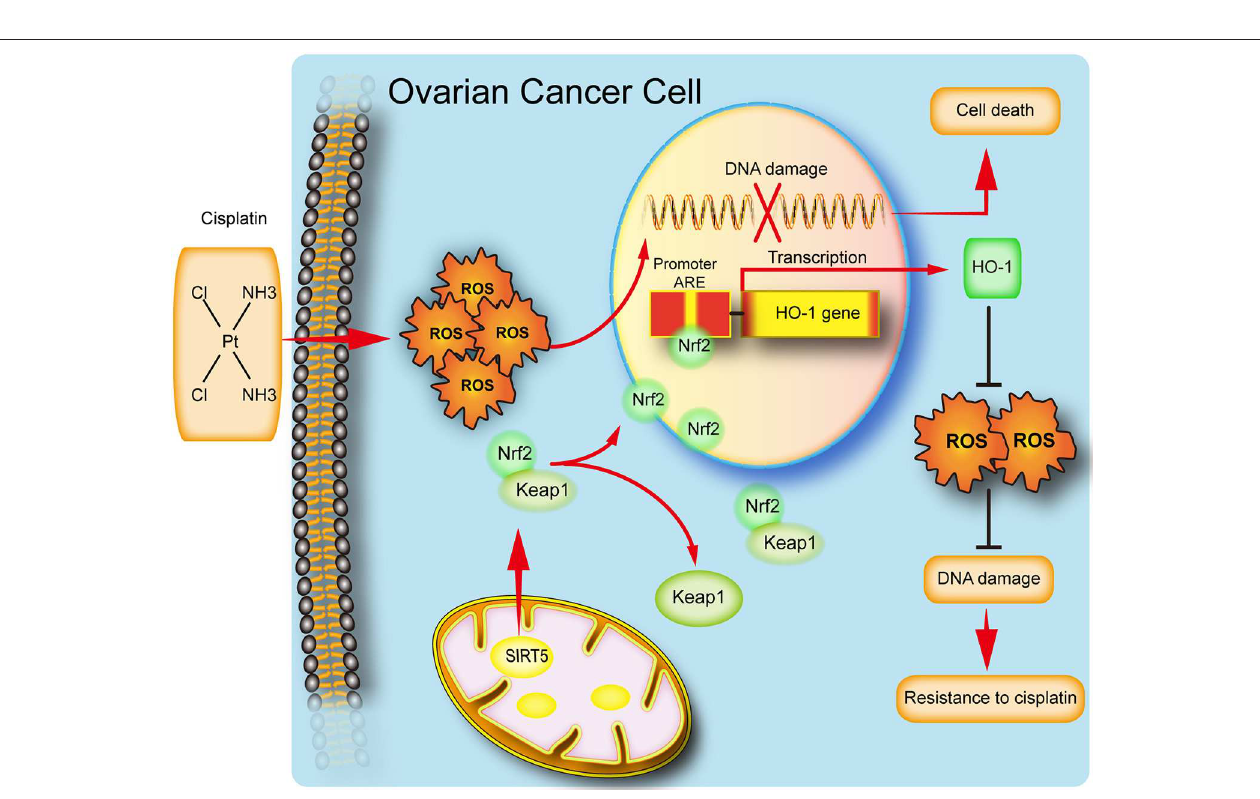
FIGURE 7 | Schematic representation of SIRT5 mediated resistance of ovarian cancer cells to cisplatin.SIRT5 positively regulates Nrf2, resulting in the nuclear translocation of Nrf2. Nuclear Nrf2 binds to antioxidant responsive elements(ARE) and activates HO-1 transcription and thus eliminates cisplatin induced ROS, leading to inhibition of DNA damage and finally cisplatin